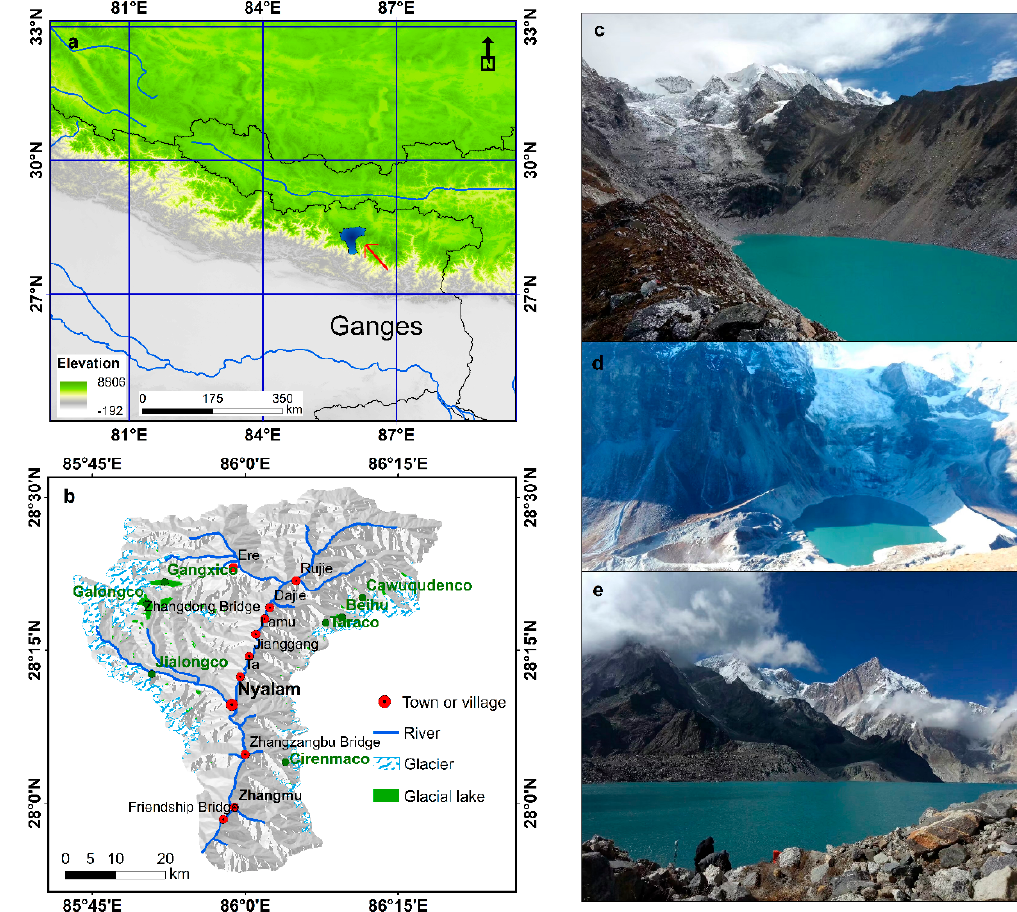
Figure 1. Study area. ( a ) Location of Poiqu River basin on regional map; ( b ) Poiqu River basin; ( c – e ) photos taken from a field investigation in October 2020, including ( c ) Cirenmaco, ( d ) Jialongco, and ( e ) Galongco.